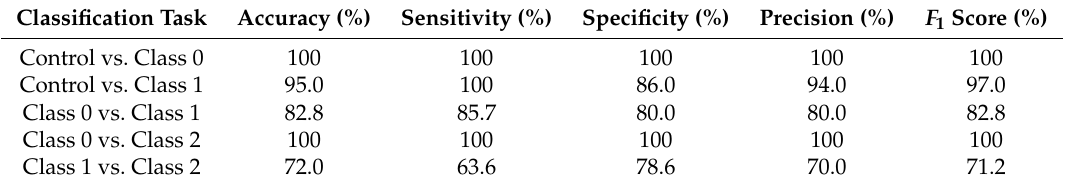
Figure 6. Confusion matrices obtained with three binary SVM classifiers. Label − 1 and 0 and 2 denote control, class 1 and class 2 subjects respectively. Table 6. Classification performance achieved using the three binary SVM